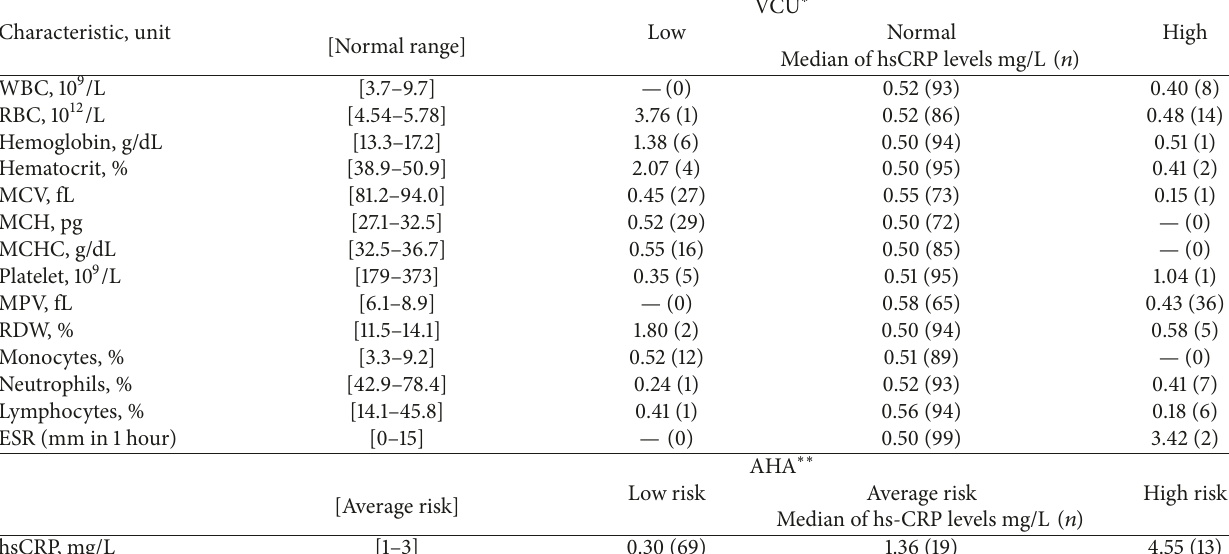
reference ranges. Median of hsCRP levels (mg/L) and participants numbers (𝑛) of each group were shown (𝑛 = 101) . Damascus,